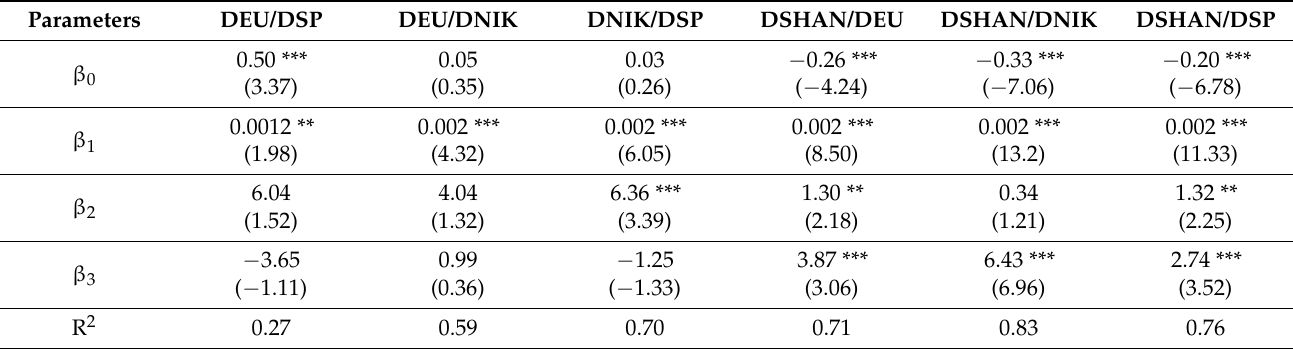
Table 7. Dynamic Conditional Correlations and Conditional Volatilities. (Stock Returns Correlations). Sample 2000M11– 2019M3 (221